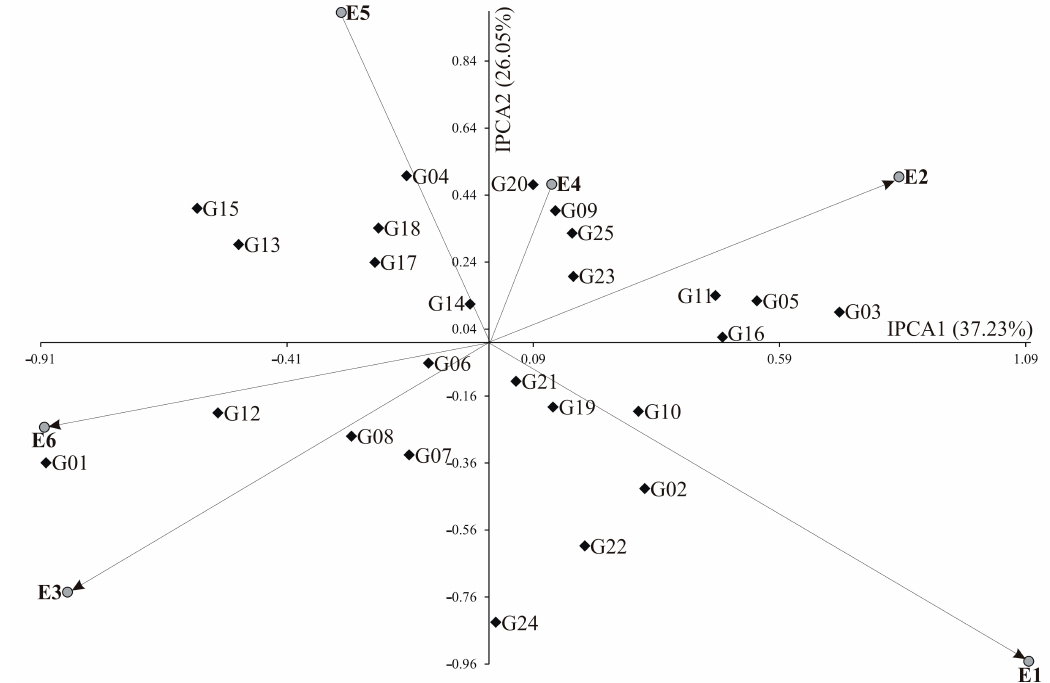
Figure 7. Biplot for genotype by environment interaction of protein content in 25 winter oilseed rape ( B. napus ) genotypes in six environments, showing the effects of primary and secondary components (IPCA 1 and IPCA 2, respectively) (E1—Borowo, 2015; E2—Borowo, 2016; E3—Borowo, 2017; E4— Ł agiewniki, 2015; E5— Ł agiewniki, 2016; E6— Ł agiewniki, 2017).